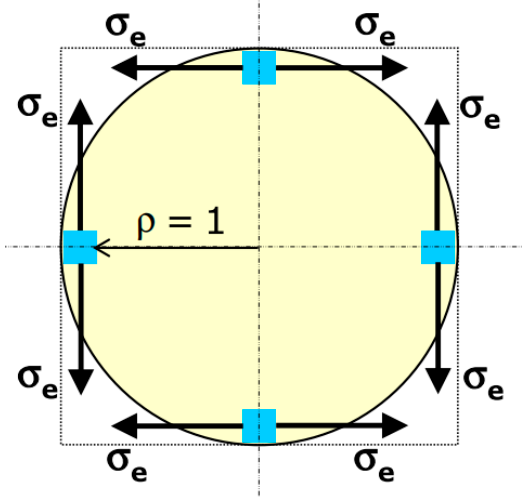
Figure 5. Schematic representation of circumferential (hoop) stress at the edges of a glass panel under radiant thermal loading, with evidence of tensile stress at the edge which may cause thermal crack (blue dots). Figure reproduced from [33] with permission from Elsevier, license number 4996990464010, January 2021.